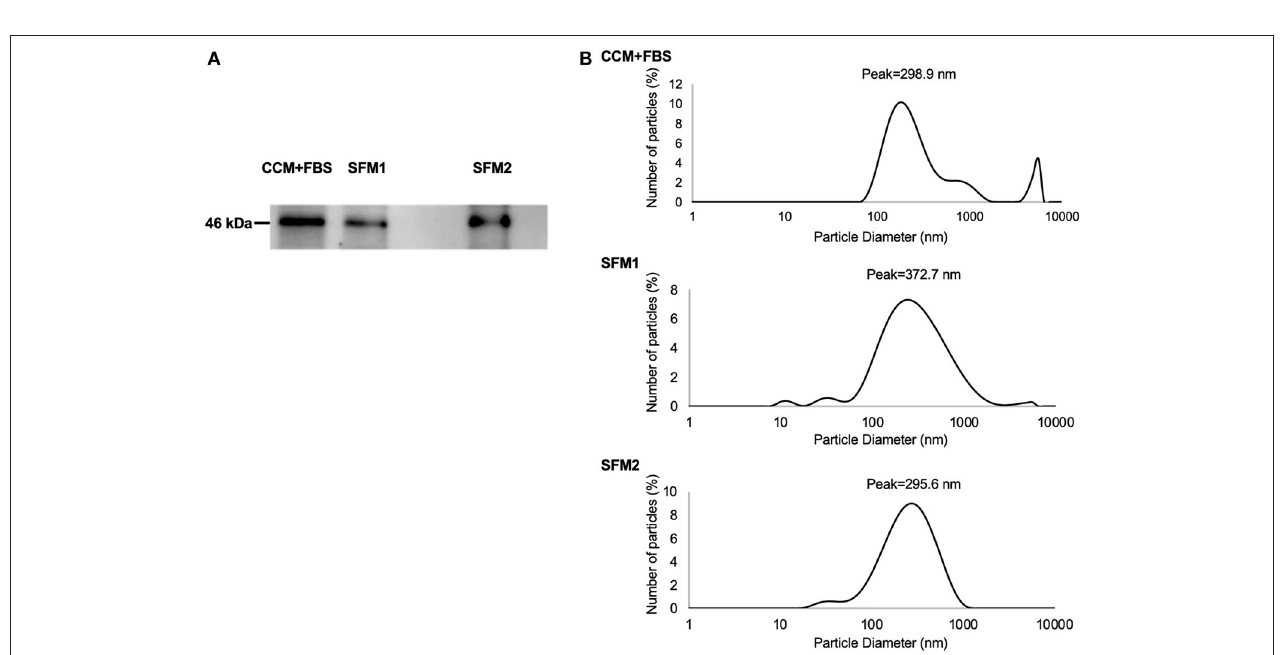
FIGURE 4 | Characteristics of MSC-derived EVs. (A) Expression of TSG101 of MSC-derived EVs from CCM + FBS, SFM 1 and SFM 2. (B) Diameter of MSC-derived EVs from CCM + FBS, SFM 1 and SFM 2 with scattering intensity peaks at about 298.9, 372.7, and 295.6nm.